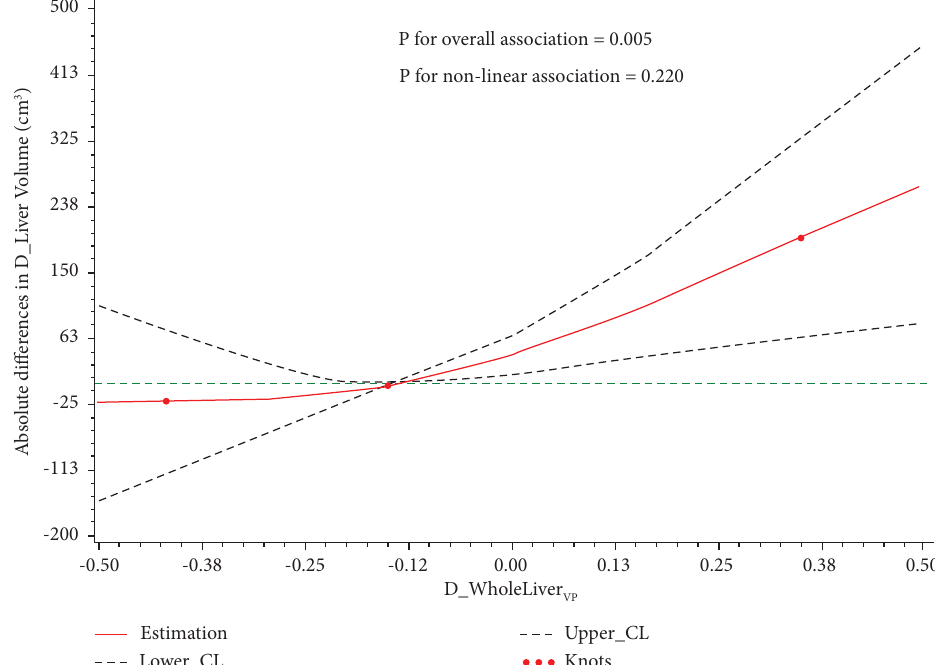
Figure 3: Restricted cubic spline models of association of the change of whole liver parenchyma iodine density at venous phase (D_WholeLiver VP ) with the change of liver volume (D_LiverVolume). Te reference is the median of D_WholeLiver VP levels; dashed lines represent 95% confdence intervals; and red knots represent D_WholeLiver VP at the 15th, 50th, and 85th percentiles. D_WholeLiver VP : the change of whole liver parenchyma iodine density at venous phase; D_LiverVolume: the change of liver